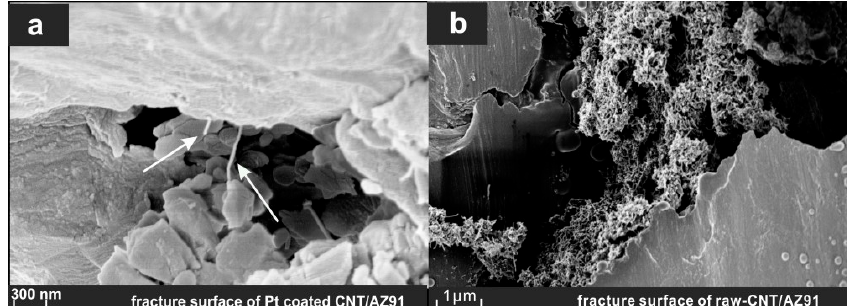
Figure 6. Fracture surface of ( a ) Pt coated CNT/AZ91 composite and ( b ) raw CNT/AZ91 composite after compression test. Arrow points at the individual CNT pulled out of the fracture surface after failure.